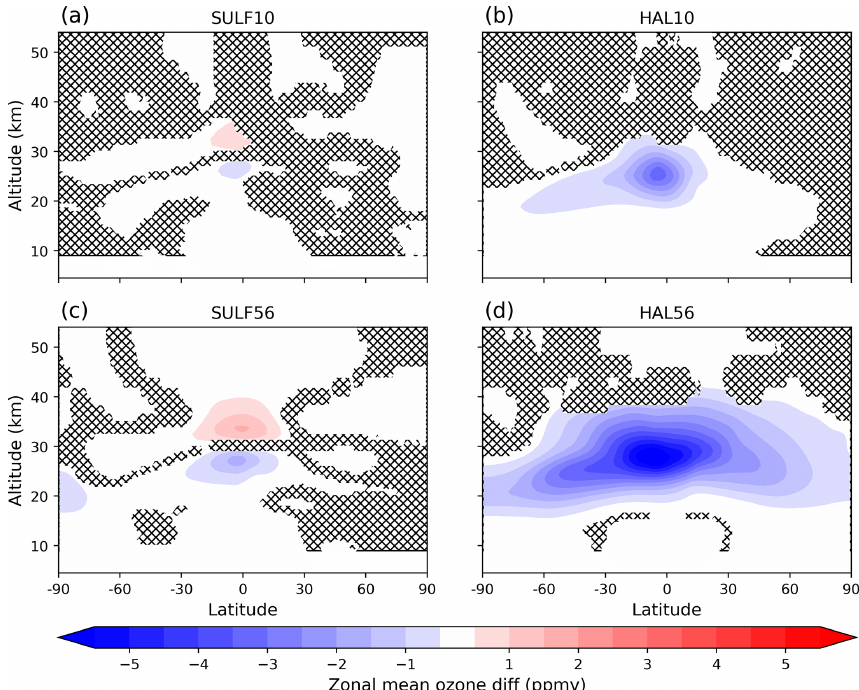
Figure 6. Zonal-mean ozone anomaly (ppmv) averaged over the first post-eruption year relative to the control climatology: (a) SULF10, (b) HAL10, (c) SULF56, and (d) HAL56. Red colours indicate ozone enhancement, and blue colours indicate ozone depletion. Anomalies that are not significant at the 95% confidence interval according to a Mann–Whitney U test are indicated with